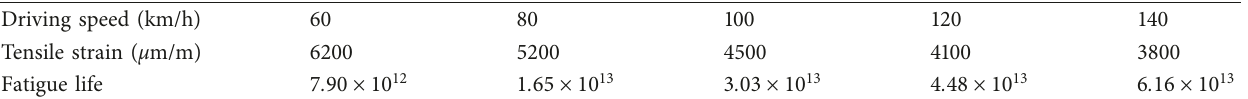
Table 11: The tensile strain and fatigue life of the asphalt pavement subjected to different driving speeds after loading cycles of 1 × 10 6 . Driving speed (km/h)